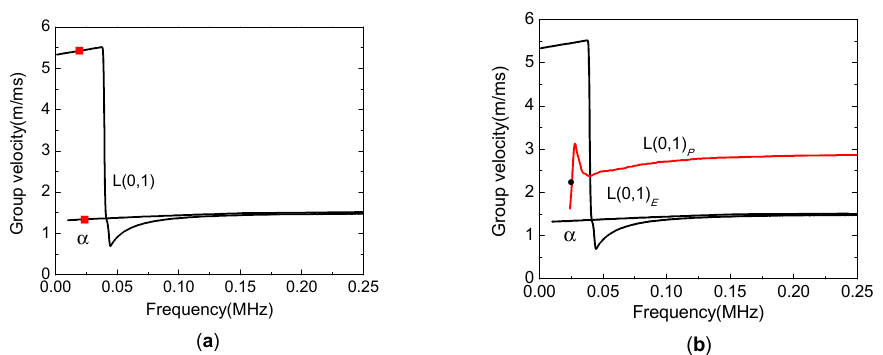
Figure 8. Group velocity dispersion curves of the first three orders of modes in the water-filled pipe embedded in ( β = 0.1) ( a ) infinite porous medium and ( b ) finite porous medium.